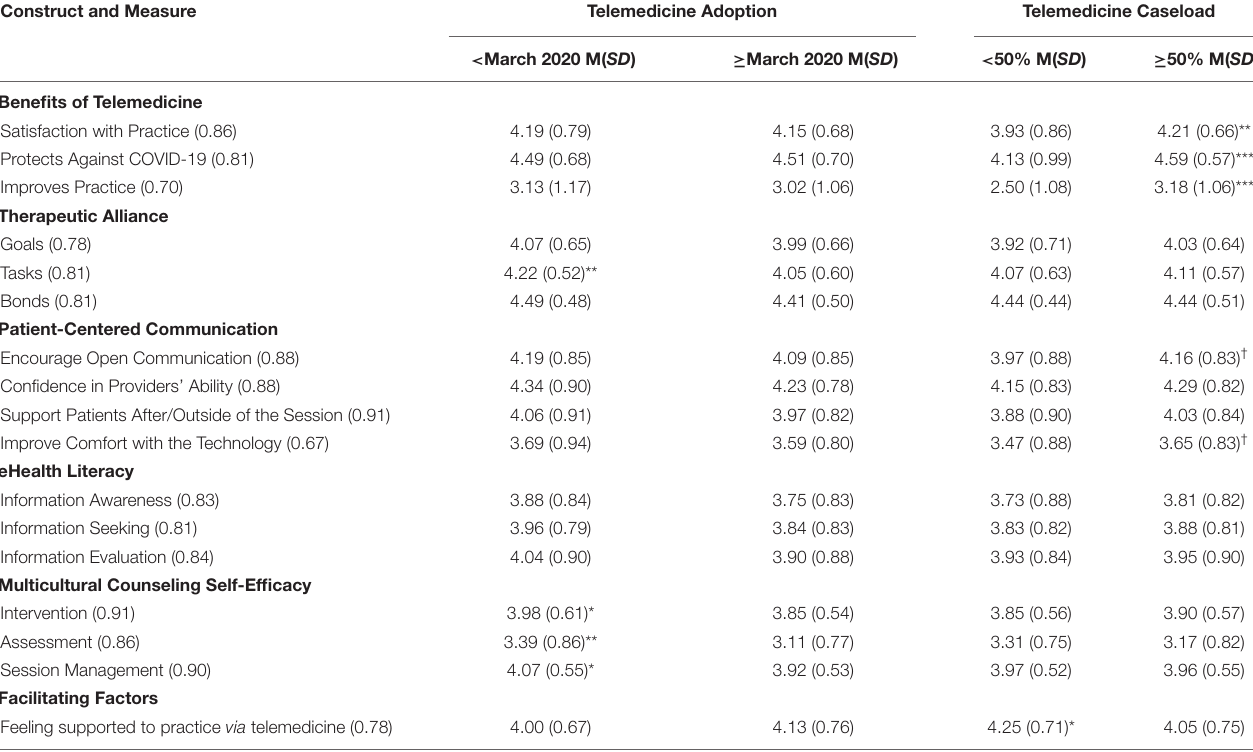
TABLE 1 | Perceptions of care by telemedicine adoption and caseload. Construct and